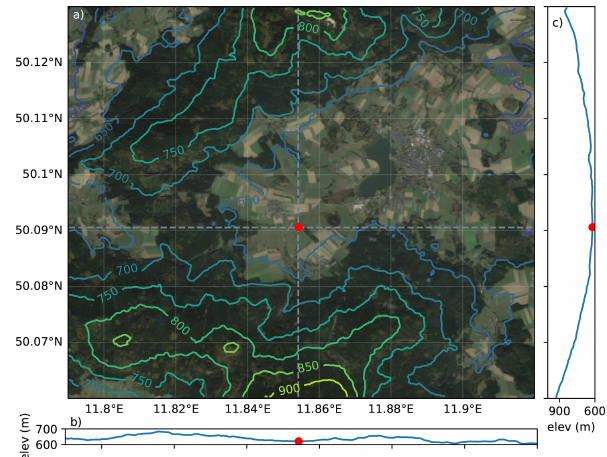
Figure 1. (a) The larger environment surrounding LOVE19 (red dot) with 50m elevation contours from the Shuttle Radar Topog- raphy Mission (Farr et al., 2007). Dashed grey lines indicate the (b) the east–west and (c) north–south elevation transects. Map data © 2021 Google, map imagery © GeoBasis-DE/BKG 2021, Geo- Content, and Maxar